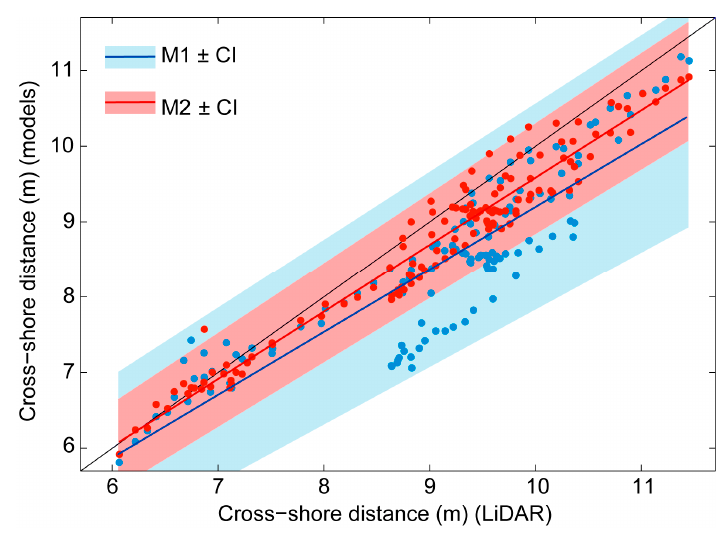
Figure 11. Regression analysis of the cross-shore locations of the shoreline ( rfl ) between each video shoreline elevation model and LiDAR data (M1: blue. M2: red.; ± confidence intervals (CI)). The black line represents the 1:1 line. Table 1. Regression analysis results and skills for the shoreline elevation models according to the evaluated morphological metrics (MD: mean deviation; MAD: mean absolute deviation).